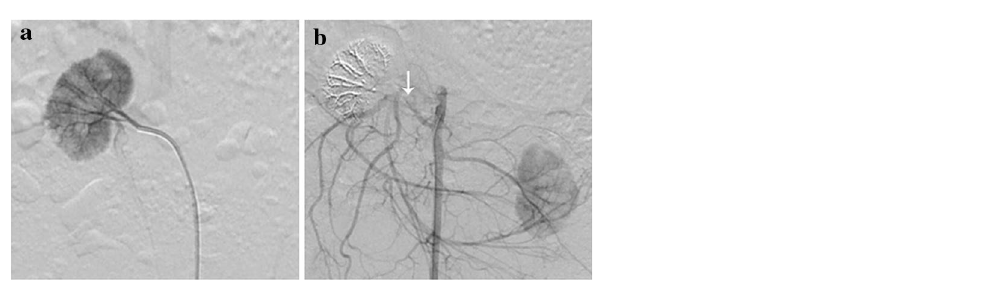
Figure 2. Right renal artery angiography of rabbits. ( a ) Before embolization. ( b ) After embolization. The white arrow indicates that the right renal artery is